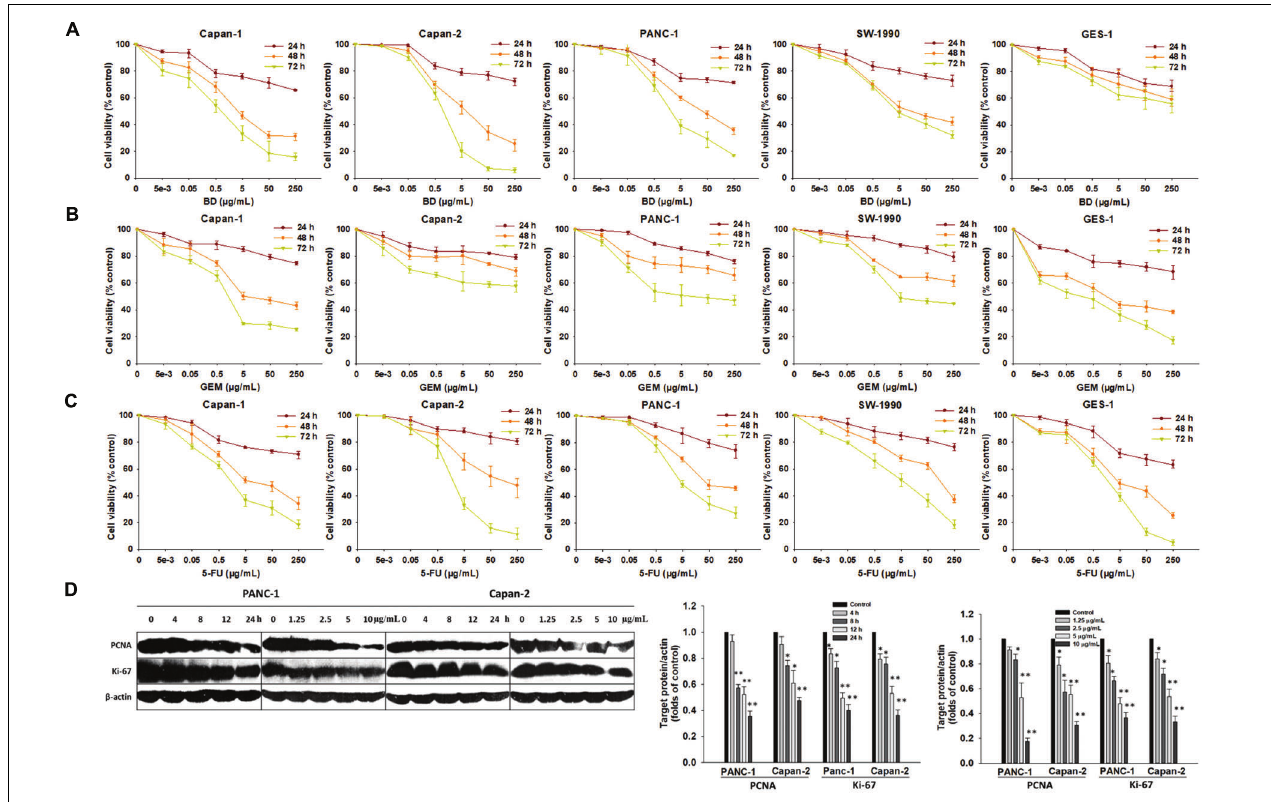
FIGURE 1 | Anti-proliferative effects of BD, GEM, and 5-FU on PanCa cells and non-tumorigenic GES-1 cell lines. (A–C) Cells were treated with either increasing concentrations of BD (A) , GEM (B) , or 5-FU (C) for 24, 48, and 72 h and subjected to MTT assay. (D) The protein expression of PCNA and Ki-67 was detected by Western blotting after different doses of BD treatments for 12 h, and 5 µ g/mL of BD treatment for 4–24 h. β -Actin served as the protein loading control. Each bar represents means ± SD of three separate experiments. ∗ P < 0.05 and ∗∗ P < 0.01 vs the control group.